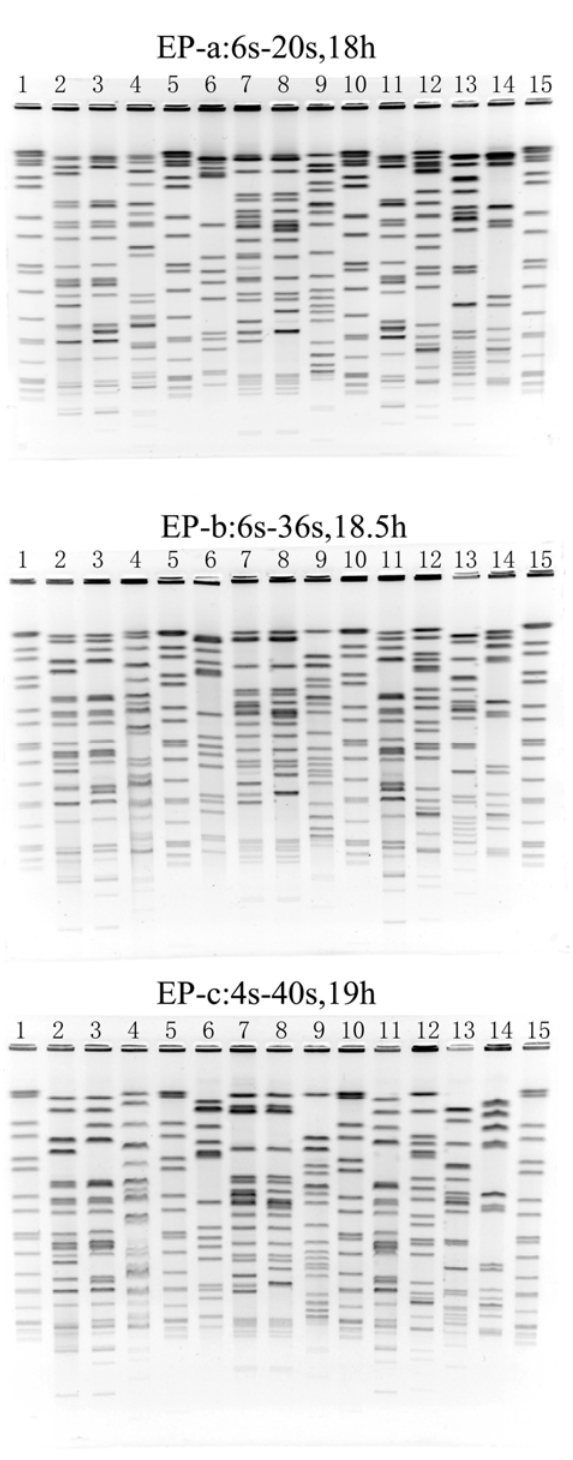
Figure 1. PFGE images obtained using three EPs with Xba I digestion. Lands 1, 5, 10, 15 were DNA size marker Salmonella serotype Braenderup H9812. Lands 2–4, 6–9, 11–14 were tested K.